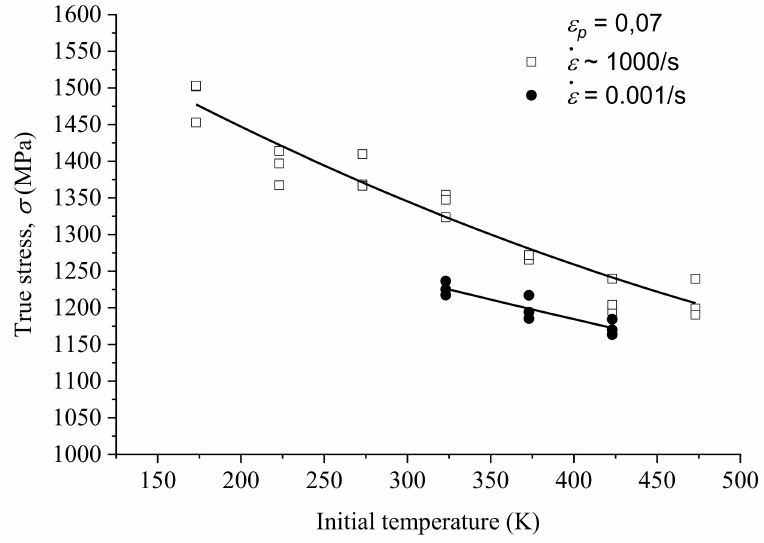
Figure 6. True stress vs. initial temperature, in quasi-static and dynamic conditions, under compression. Experiments have highlighted the effect of strain rate and temperature on the mechanical behavior of the studied HSS